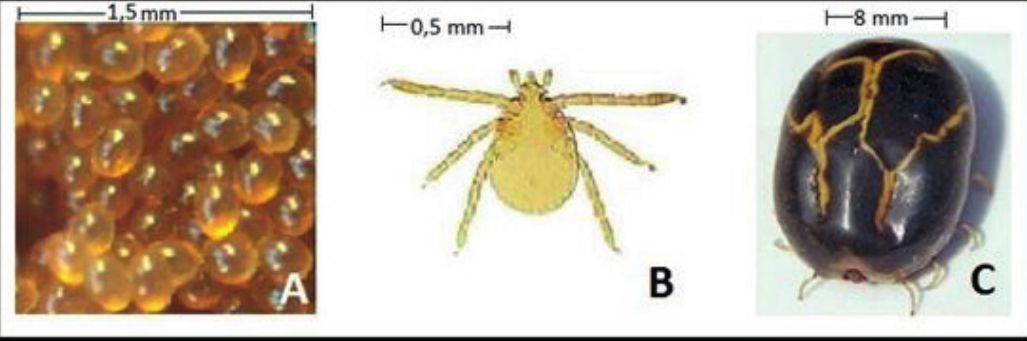
Figure 5 - Tick Rhipicephalus (Boophilus) microplus : ( a ) eggs; ( b ) larvae; ( c ) adult females. Photos Camila Mattos.